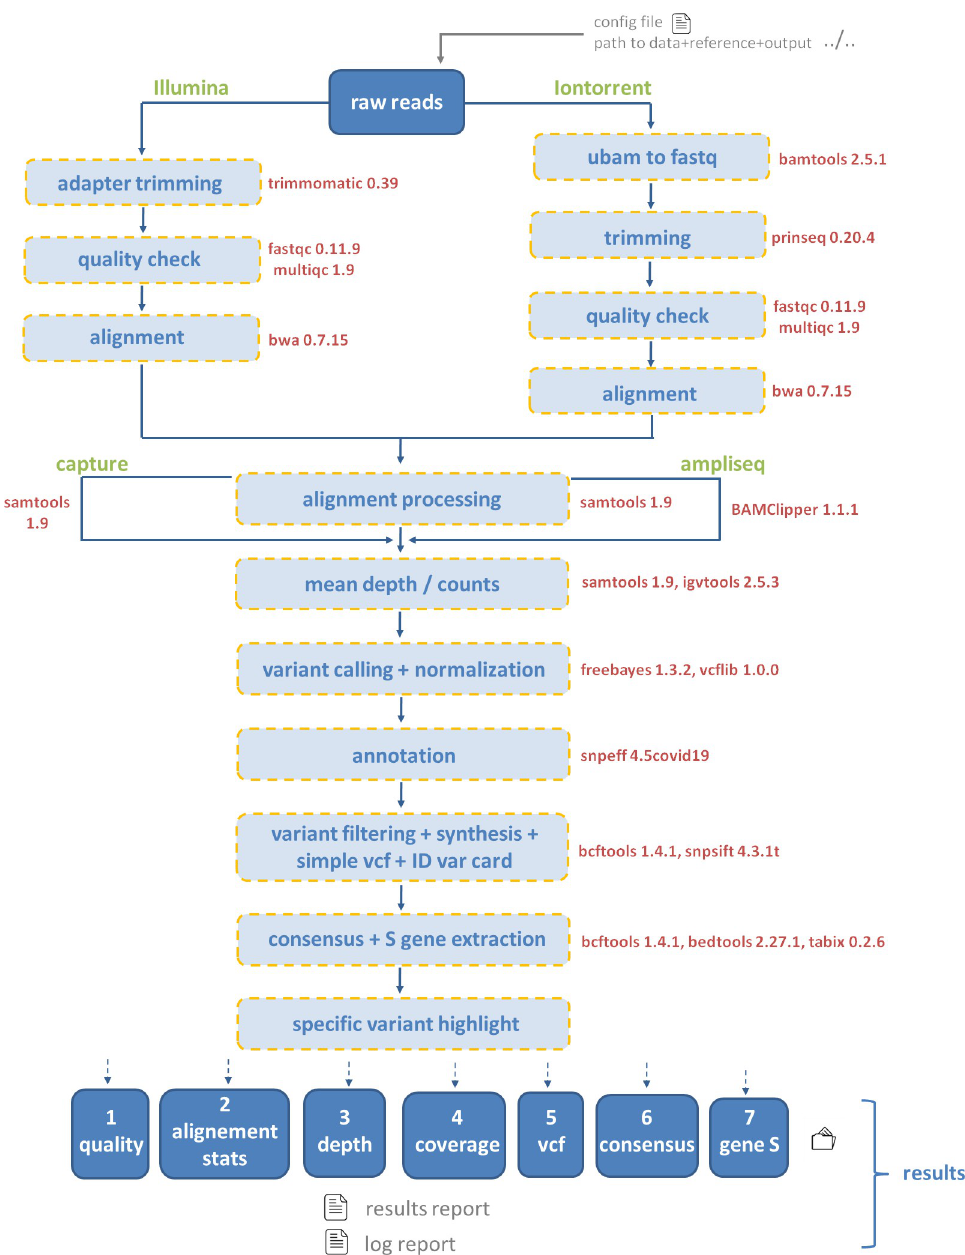
Fig 1. Overview of ASPICov steps and software implemented. In red: Software used, green: Option used.